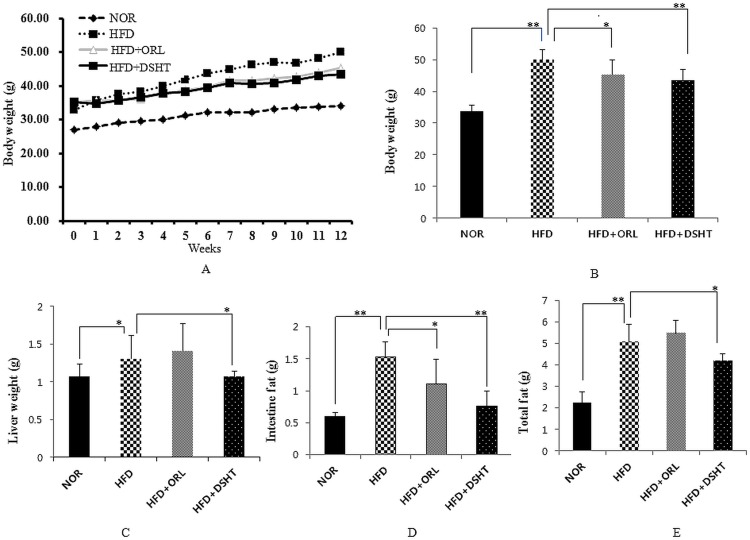
Effect of DSHT on total body weight (gain), liver weight, intestinal and total fat of HFD-fed C57BL/6 mice.(A) Total body weight of normal (NOR), high fat diet (HFD), orilistat (ORL) or daesiho-tang (DSHT) fed animals measured weekly. (B) The total body weight of NOR, HFD, HFD+ORL and HFD+DSHT fed animals after 12 weeks. (C) The liver weight of NOR, HFD, HFD+ORL and HFD+DSHT diet fed animals. (D) Intestinal fat of NOR, HFD, HFD+ORL and HFD+DSHT fed animals. (E) The total fat of NOR, HFD, HFD+ORL and HFD+DSHT fed animals. Data were represented as mean ± SD (n = 7). The results were compared by Student’s t-test (** corresponds to p<0.005, * corresponds to p<0.05). The error bars represent the SD.